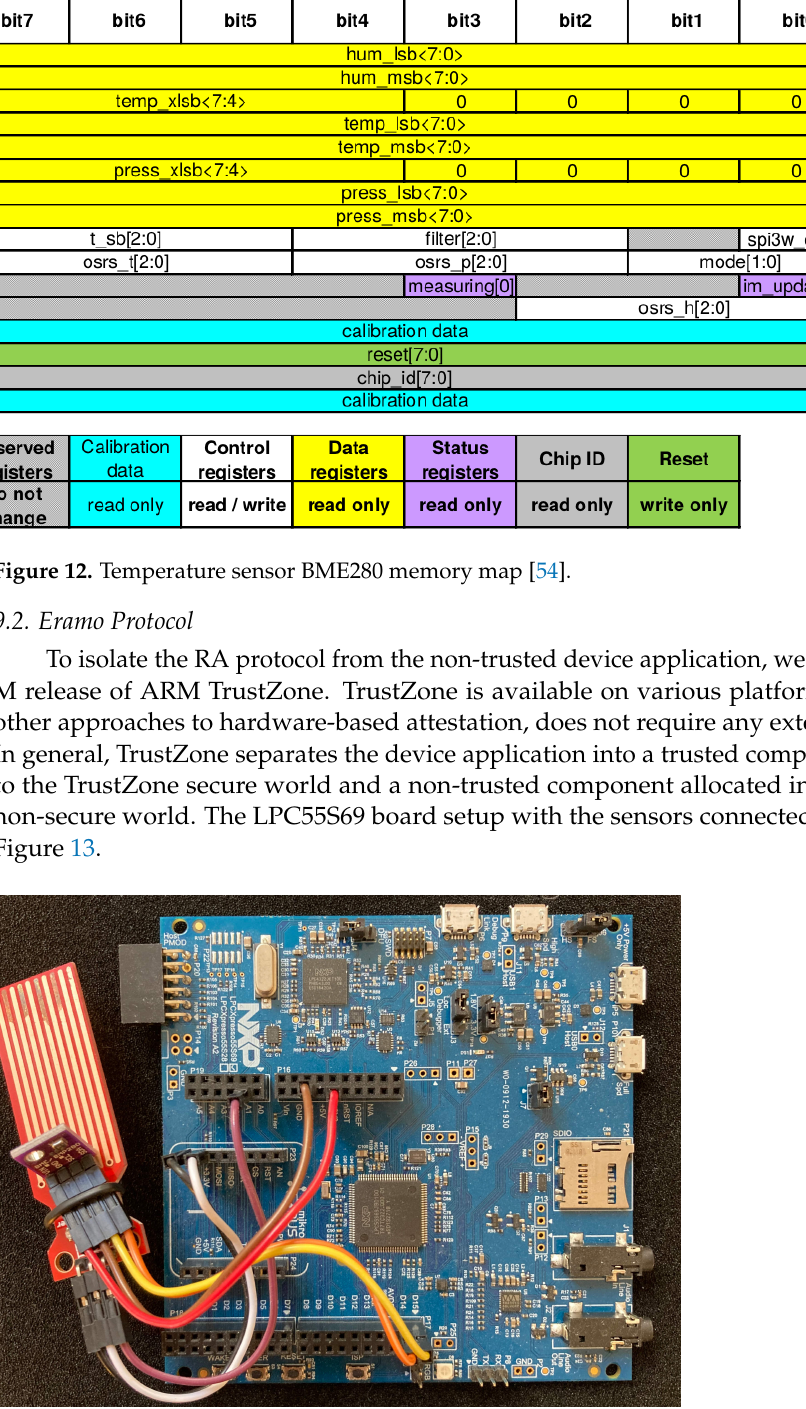
Figure 13. IoT device setup consisting of the TrustZone-enabled LPC55S69 evaluation board and the two connected